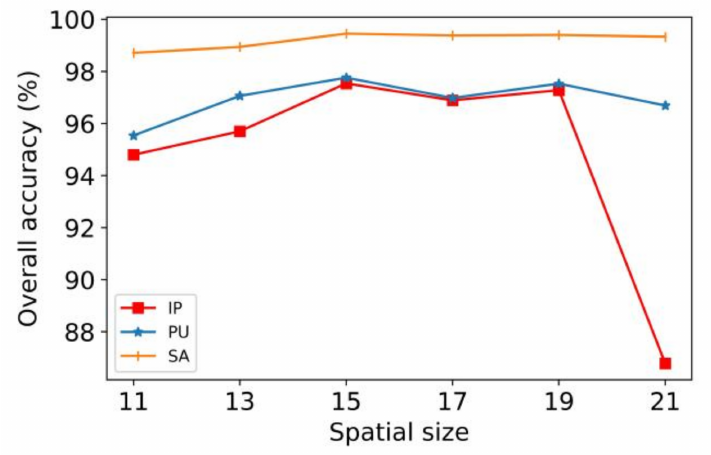
Figure 9. Performance of the proposed method with different input spatial